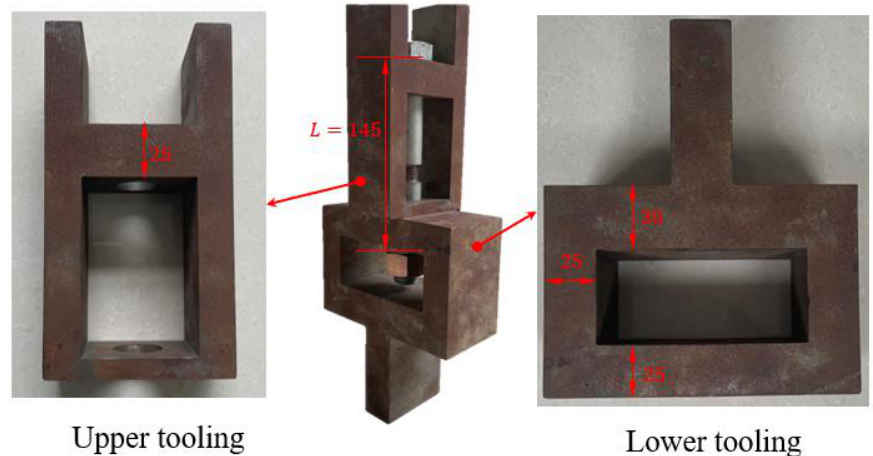
Figure 7. Clamping tooling design diagram (unit: mm).